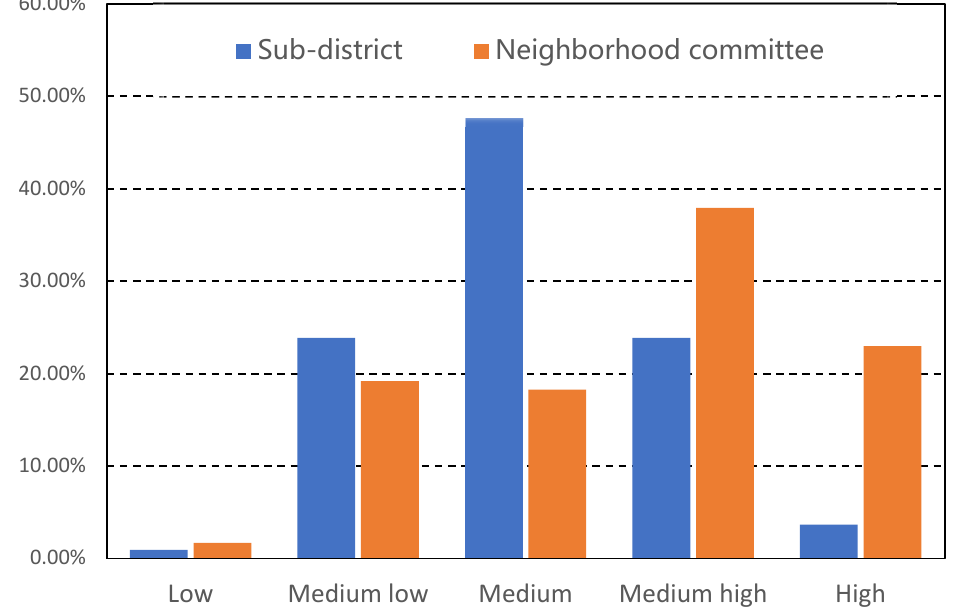
Figure 9. Histogram of sub ‐ districts and neighborhood committees across different vulnerability levels.